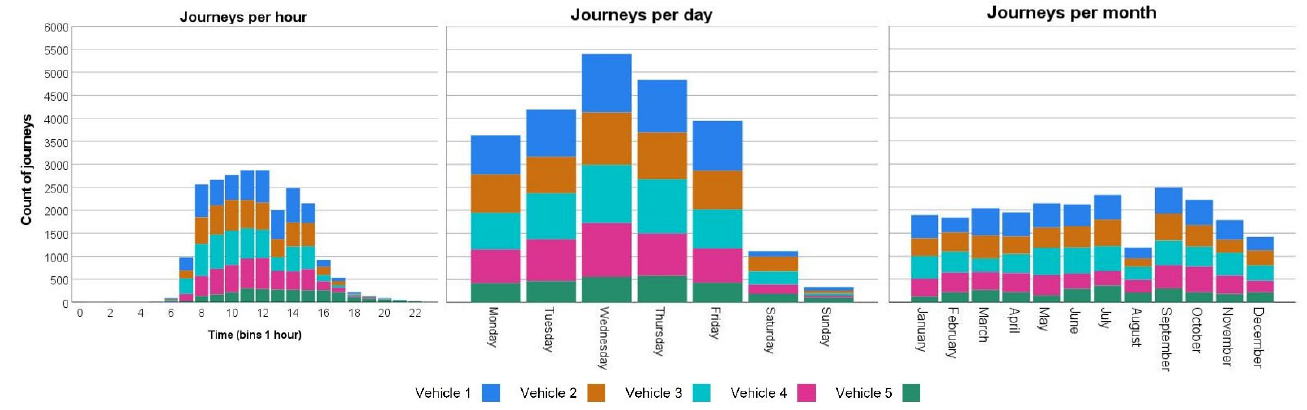
Figure 4. Distribution of the number of journeys for each vehicle per hour of the day, day of the week, and month of the year .